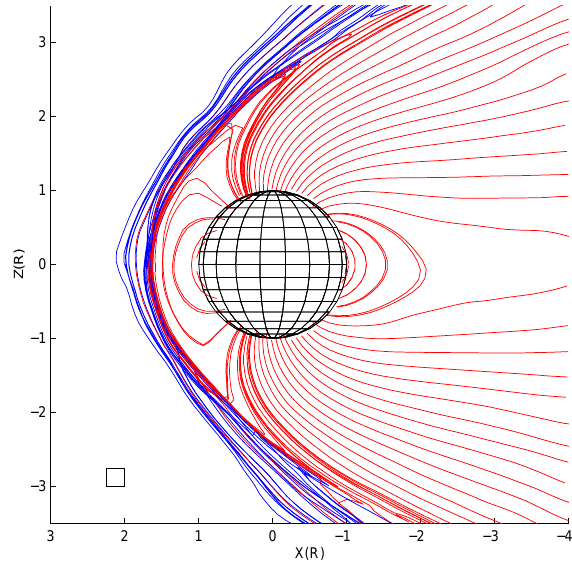
Fig. 1. Morphology of the magnetic field in the quasi-neutral hybrid model in a pure northward IMF case. Magnetic field lines are con- nected to Mercury (red lines) and to the solar wind (blue lines). The magnetic field lines are calculated by using the following starting points: 20 starting points along two lines which go via the points (1.1,0,0) R M and ( − 1,0, +− 4) R M and 30 points along the two lines via the points ( − 1,0,0) R M and ( − 1,0, +− 4) R M . Note that, although the starting points are on the XZ plane the magnetic field lines are not on the XZ plane. The small square on the left bottom corner shows the size of the grid which was used at the field line